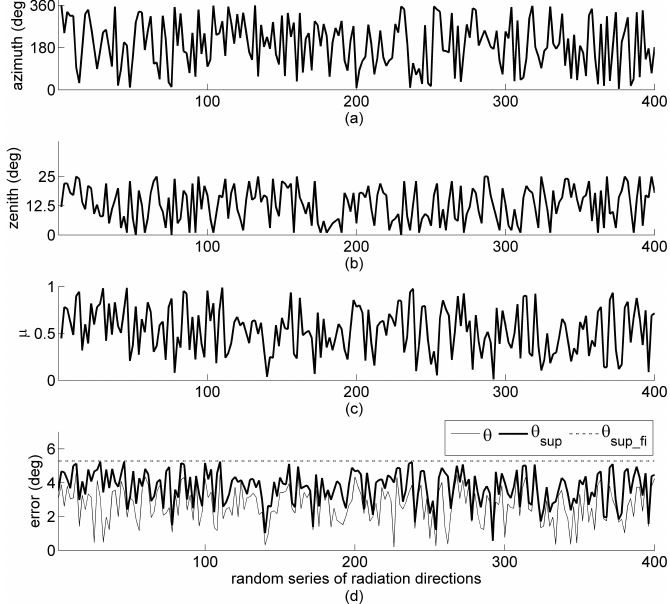
Figure 4. ( a ) Azimuth angle, ( b ) zenith angle, ( c ) ratio µ of the projected interference energy, and ( d )